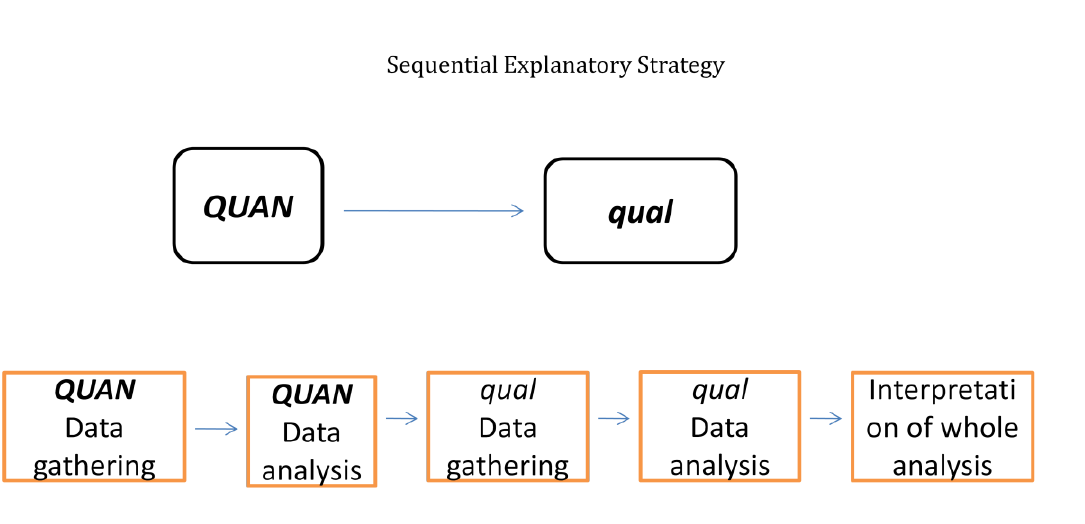
Figure 3.1 Sequential Explanatory Strategy. Source: Creswell et al,